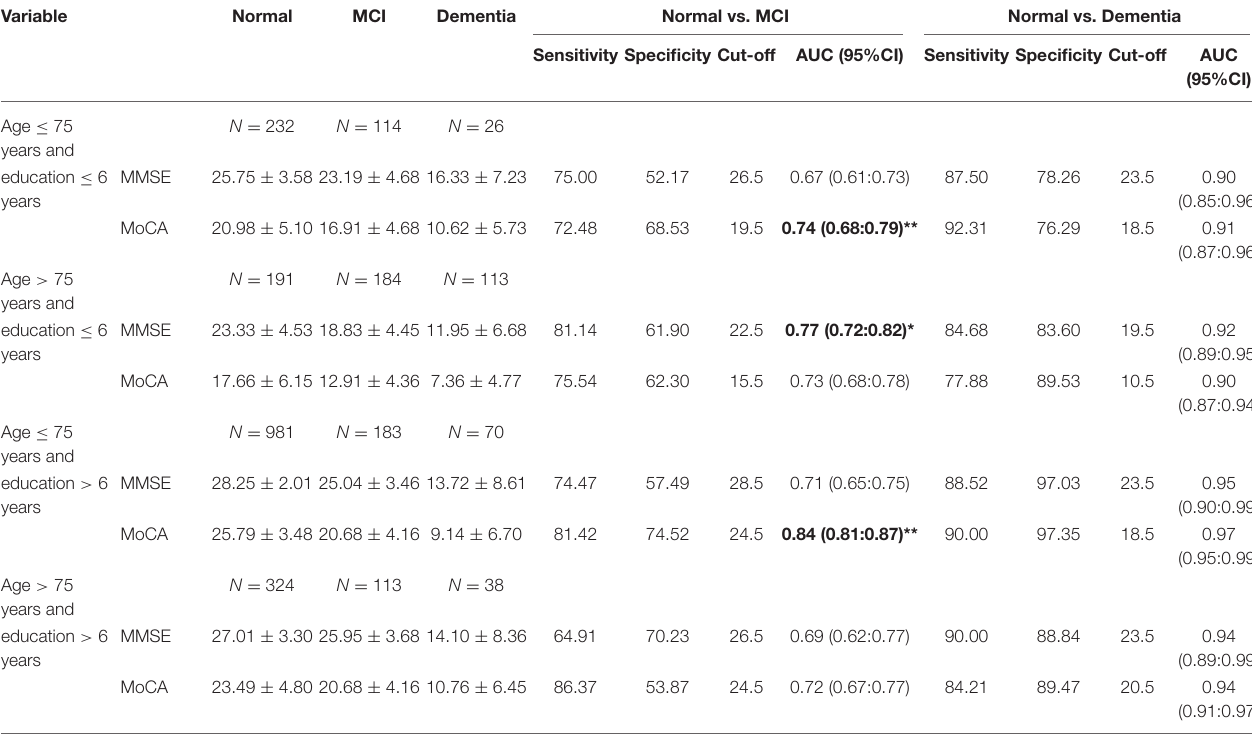
TABLE 5 | Cut-off scores, sensitivities, specificities and AUCs (95% CI) of the MoCA and MMSE between normal cognition, MCI and dementia by different educational levels within each age group.